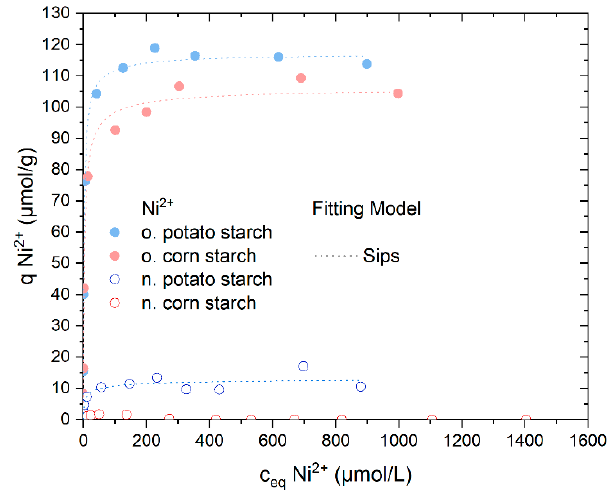
Figure 5. Adsorption isotherms for Ni 2+ from NiSO 4 solution and the respective Sips isotherm model fits. The Langmuir and the Dubinin–Radushkevich fitting are presented in Figure S7. N. potato starch is shown in blue, n. corn starch in red, o. corn starch in pink and o. potato starch in light blue. Table 2. Fitting parameters for the adsorption of Ni 2+ from NiSO 4 solution onto n. potato starch, o. potato starch and o. corn starch for Langmuir, Sips and Dubinin–Radushkevich isotherm models.